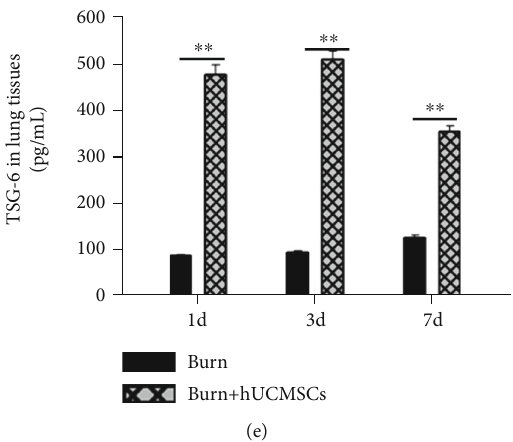
Figure 1: Secretion and knockdown e ffi ciency of the TSG-6. (a) TSG-6 levels in supernatants of control, sham serum, and burn serum groups were evaluated by ELISA. Compared with control and sham groups, the TSG-6 levels in the burn serum group were signi fi cantly increased. (b) Representative photographs demonstrated successful transfection with Lenti-GFP-siRNA (vehicle) and Lenti-TSG-6-siRNA (siTSG-6) in hUC-MSCs (the inverted fl uorescence microscope, 100x). (c) The levels of TSG-6 protein expression in hUC-MSCs after transfection with Lenti-GFP-siRNA and Lenti-TSG-6-siRNA were detected by Western blotting, and quantitative analysis is shown in the corresponding histogram. (d, e) TSG-6 levels in lung tissue and serum of burn and burn+hUC-MSC groups were also evaluated using ELISA. TSG-6 level of the burn+hUC-MSC group was signi fi cantly higher than that of the burn group. Values are represented as mean ± SD ( n = 6 ). Asterisk ( ∗ ) and double asterisk ( ∗∗ ) stand for p < 0 : 05 and p < 0 : 01 ,